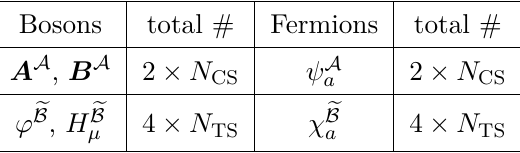
Table 6 . The summary of on-shell component fields in the CS+TS+nTS-B model. From L + L + L , the final on-shell Lagrangian can be written as CS TS n TS − B P 1 L (on-shell) = − CS+TS+nTS − B 2